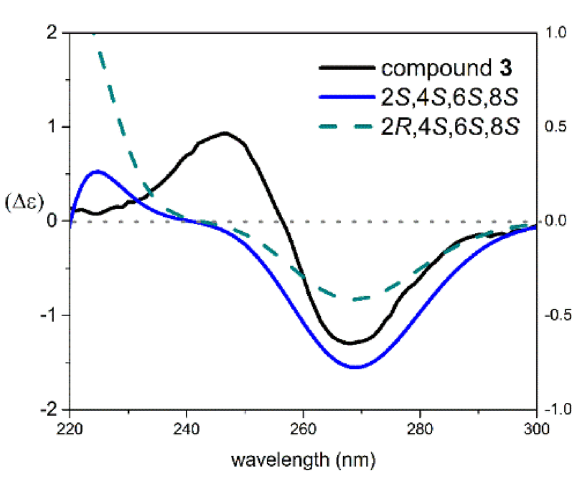
Figure 9. The experimental and TDDFT calculated ECD spectra of 3